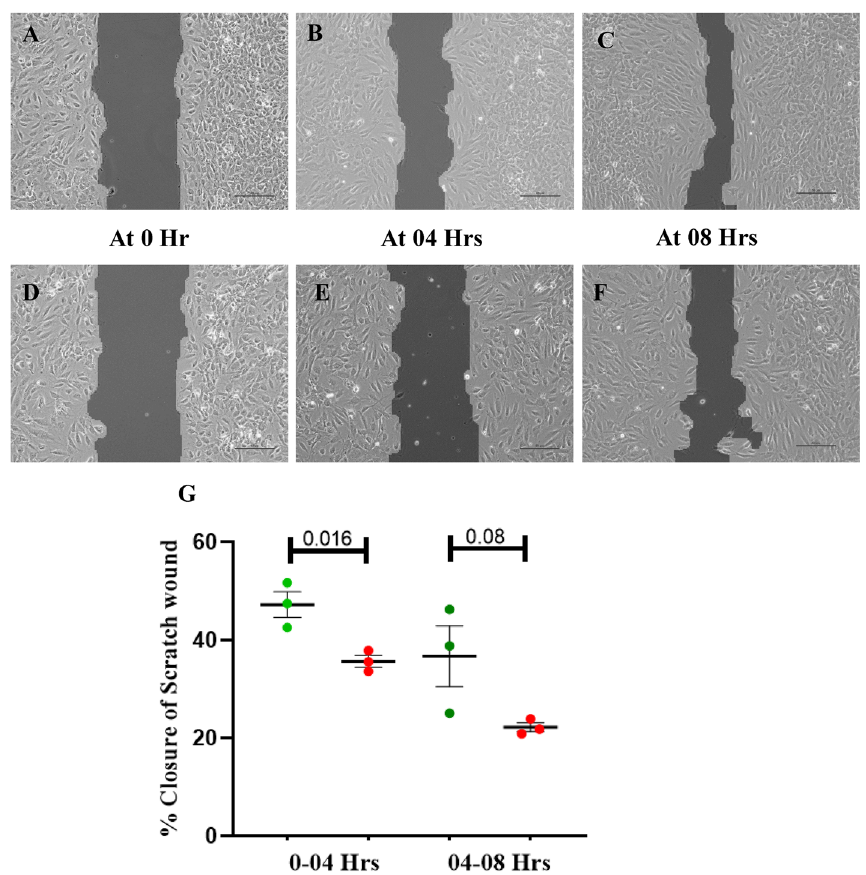
Figure 13. Effect of SIN-1 on scratch wound regression by ECFCs in vitro . Bright field phase contrast microscopic images (10x) of in vitro scratch wound assay at 03 different time points (0 h, 04 h and 08 h) is depicted in ( A – F ). Images ( A – C) shows 10 × image of wound closure in untreated; ( D - F ) shows wound closure in SIN-1 treated group at three different time points 0 h, 04 h and 08 h; Scale bar 100 µm; ( H ) shows % in vitro scratch wound closure by ECFCs at two different time points from 0 to 04 h and 04 to 08 h in untreated and SIN-1 treated group (n = 3 for each group). Student t-test was used to assess the significance difference. Data is represented as mean ± SE. Error bar represent standard error of mean; dots represent average values of the parameters obtained from experimental duplicates; p ≤ 0.05 considered statistically